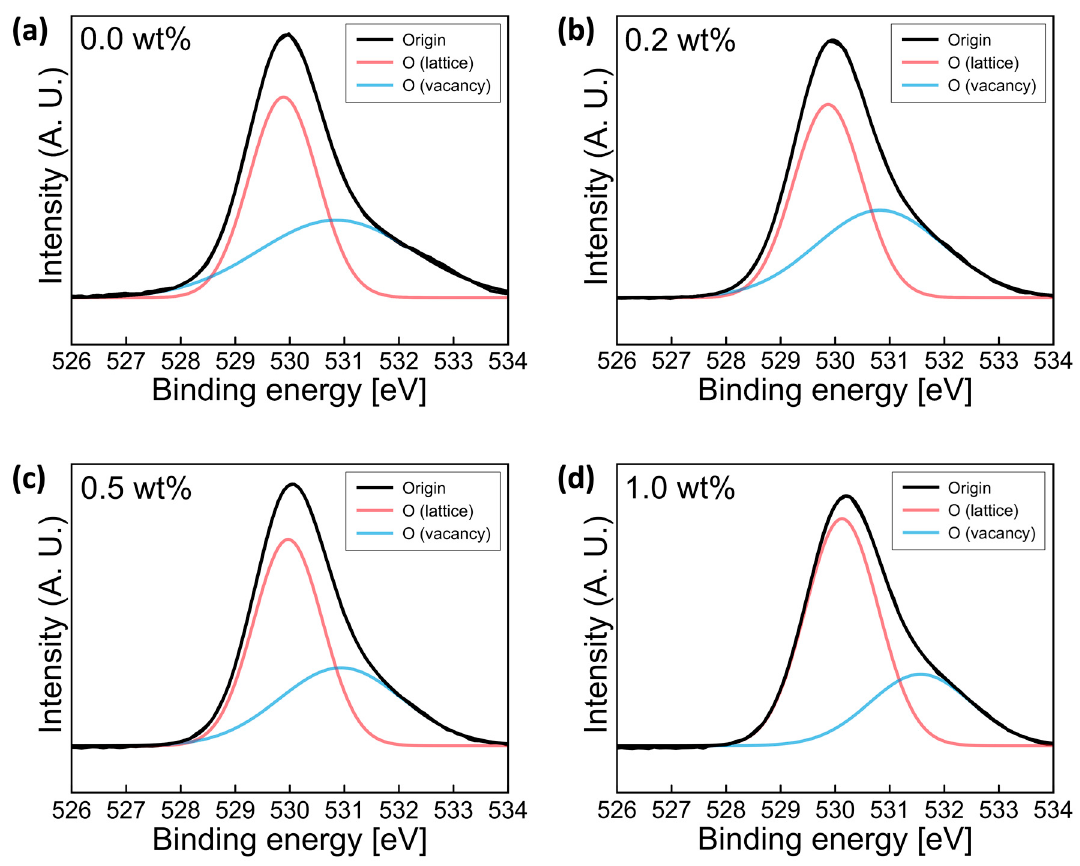
Figure 4. Deconvoluted O1s XPS spectra for Y-doped SnO 2 thin films with ( a ) 0.0, ( b ) 0.2, ( c ) 0.5, and ( d ) 1.0wt% Y annealed at 500 °C for 2 h.